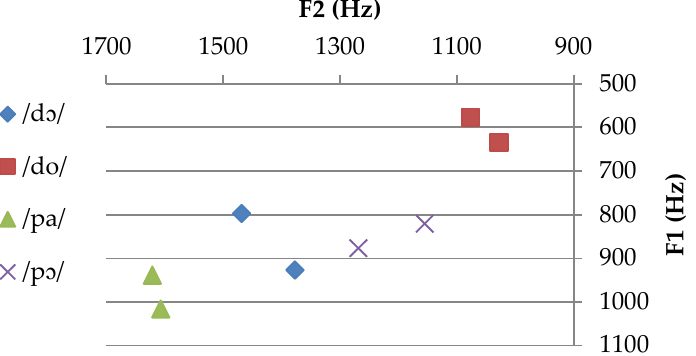
Figure 2. The stimuli used in the experiment. The Hñäñho vowels contained in the stimuli are plotted in terms of the vowel formants F1 and F2.